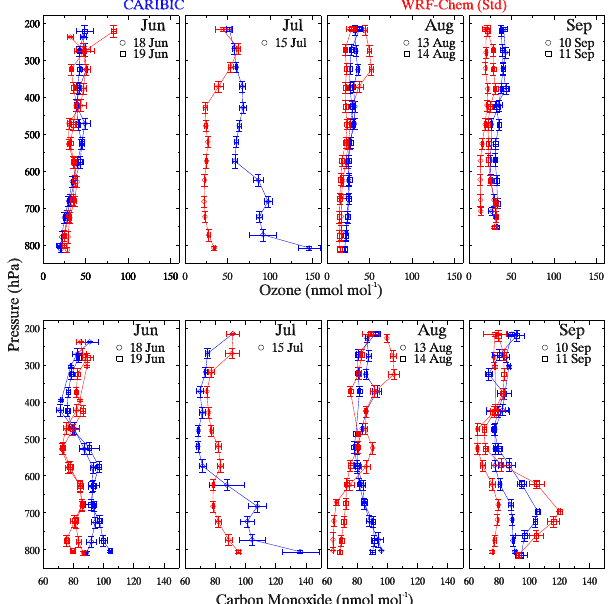
Figure 2. Comparison of ozone and carbon monoxide profiles from WRF-Chem simulations (Std, red lines) with the CARIBIC obser- vations (blue lines) during June, July, August and September 2008. Model output has been spatially and temporally interpolated along the CARIBIC flight tracks. Only data collected during the aircraft descent are shown here (see Sect. 4.1.1 for